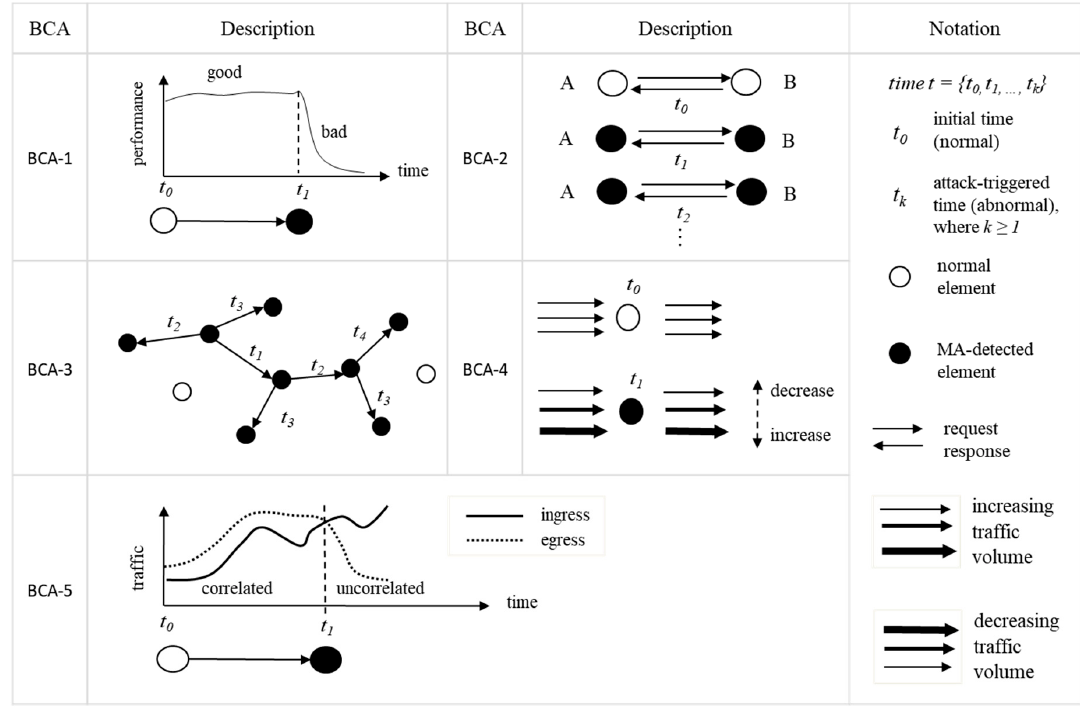
Figure 1. Key system behavior features of BCAs.